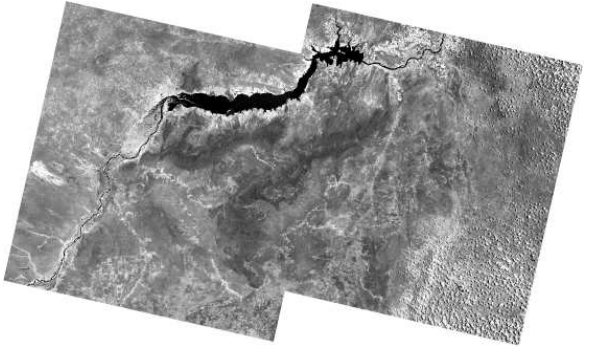
Figure 4: Mosaic of October